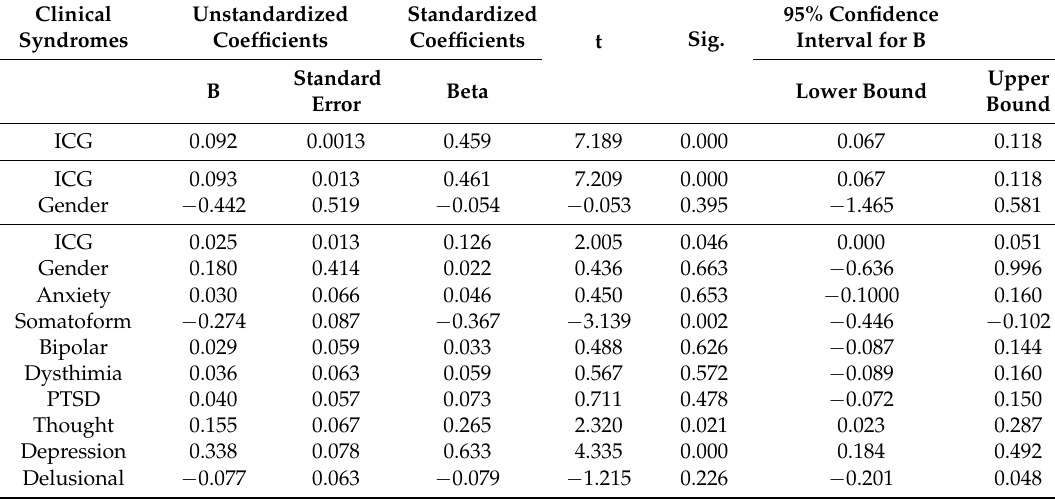
Table 3. Hierarchical linear regression analysis of clinical syndromes associated with risk of